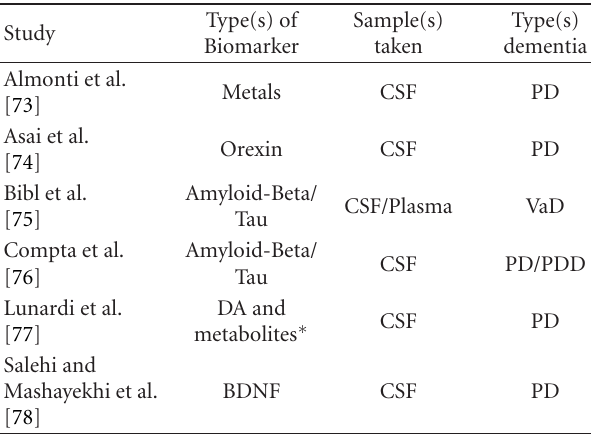
Table 4: CSF studies in Parkinson’s